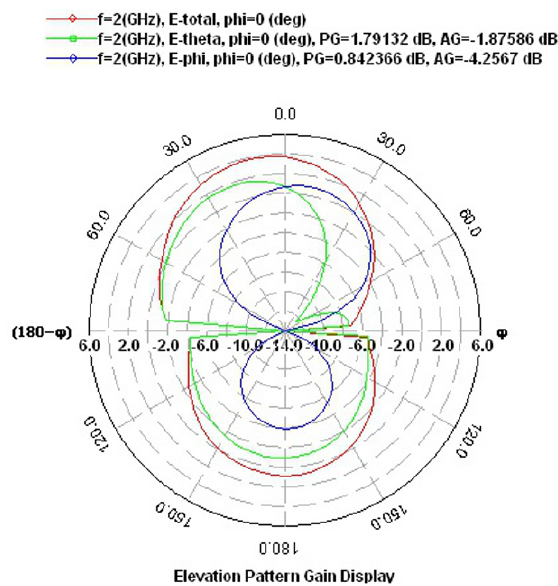
Figure 3. Radiation pattern of the proposed antenna.